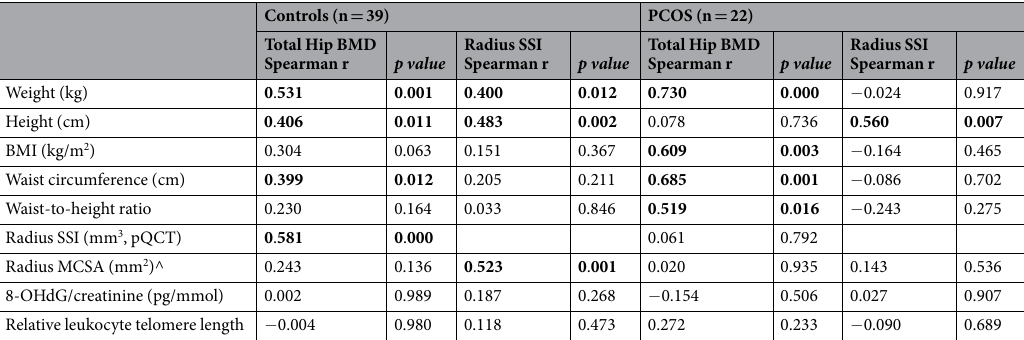
Table 3. Correlations * among total hip bone mineral density (BMD, g/cm 2 ) and the radial strength-strain index (SSI, mm 3 ) by peripheral quantitative computed tomography site in women with polycystic ovary syndrome (PCOS) and controls. * Data reported are Spearman ranked correlations with two-tailed p values. ^4 controls and 1 woman with PCOS failed the muscle cross-sectional area (MCSA) analysis due to movement